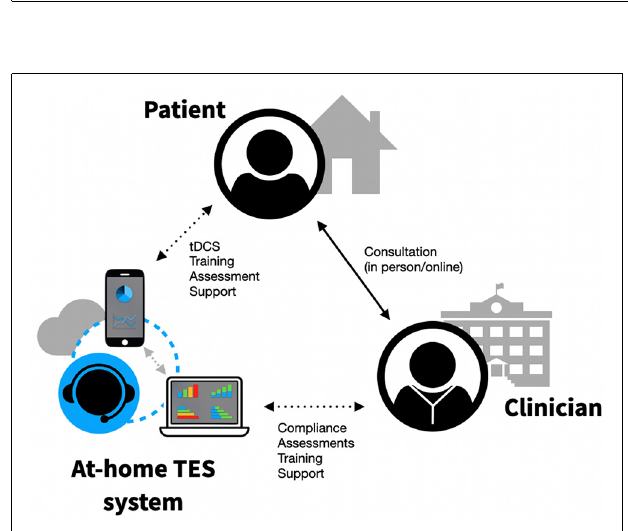
FIGURE 2 | Example of a remotely supervised, at-home TES